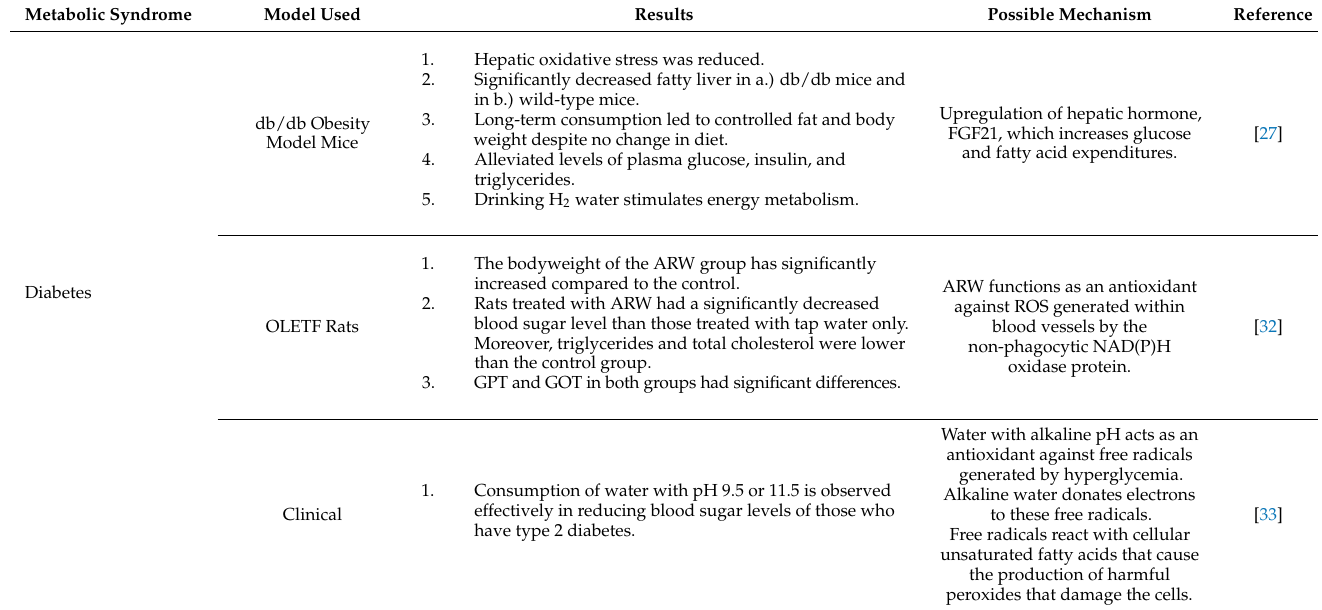
Table 1. Summary of ARW studies in metabolic